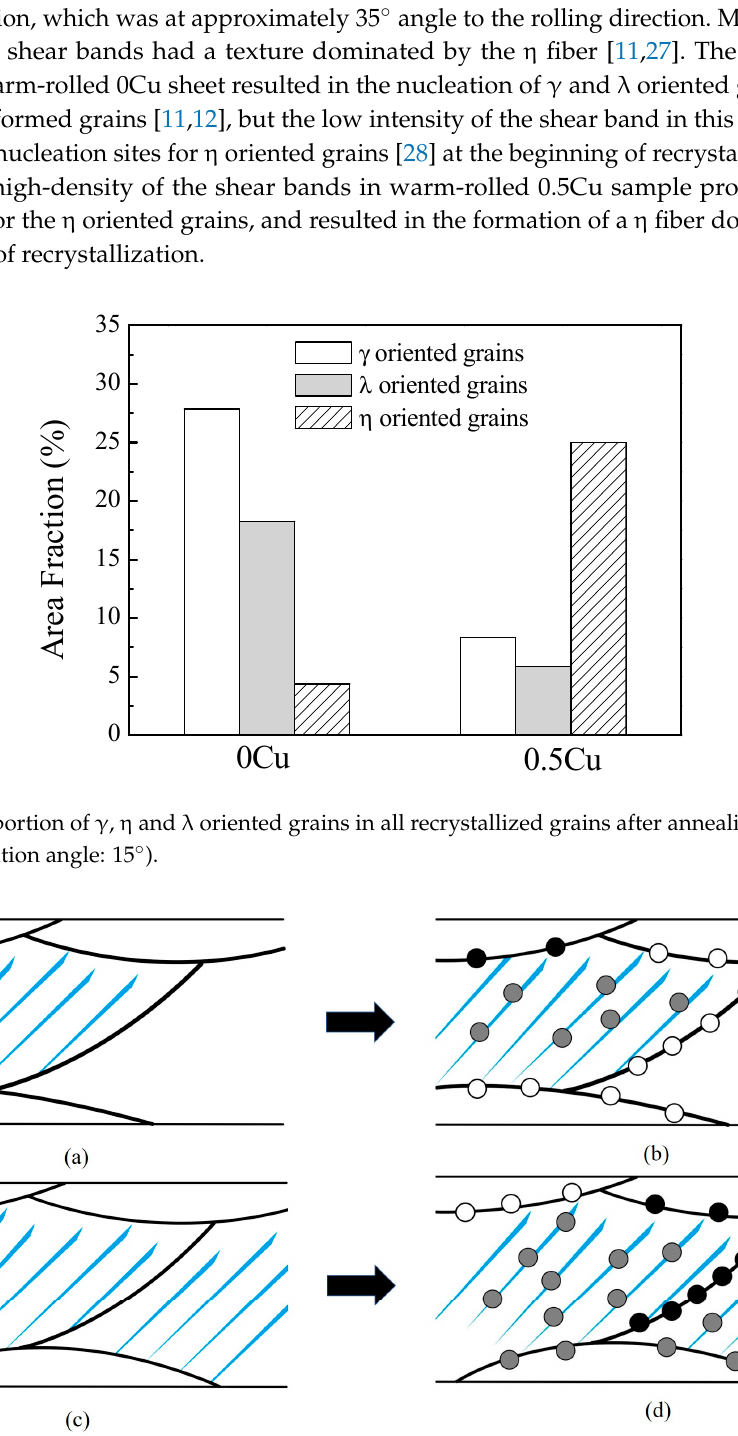
Figure 7. The schematic diagram showing the recrystallization nucleation of the warm-rolled sheets during annealing treatment: shear bands in: 0Cu ( a ); and 0.5Cu ( c ) warm-rolled sheets; and the recrystallization nucleation of: 0Cu sample ( b ); and 0.5Cu sample ( d